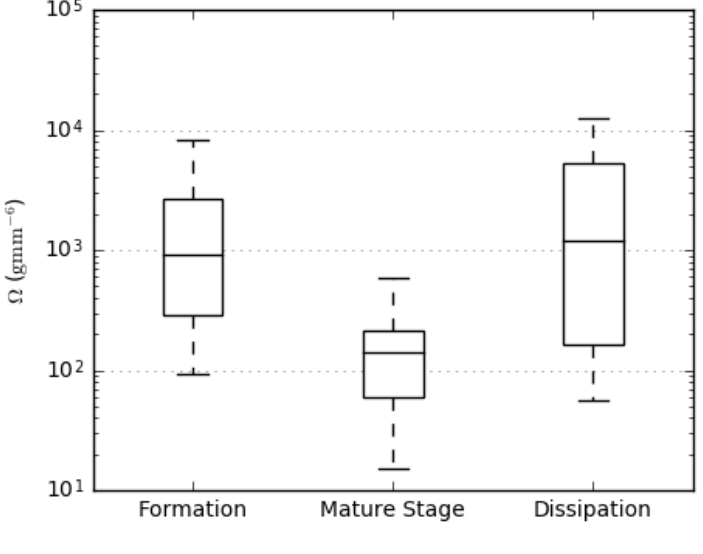
Figure 10. General tendencies of Ω